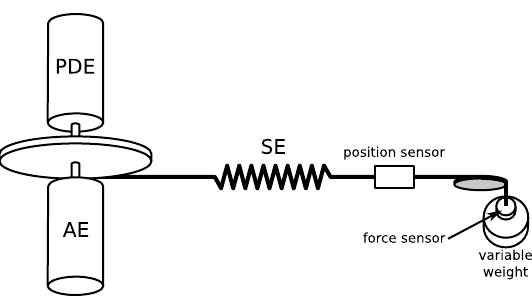
Fig. 3. Hardware design. AE and PDE were realized with electric motors, SE with a mechanical spring. A variable weight was used for the external loading of the CE.